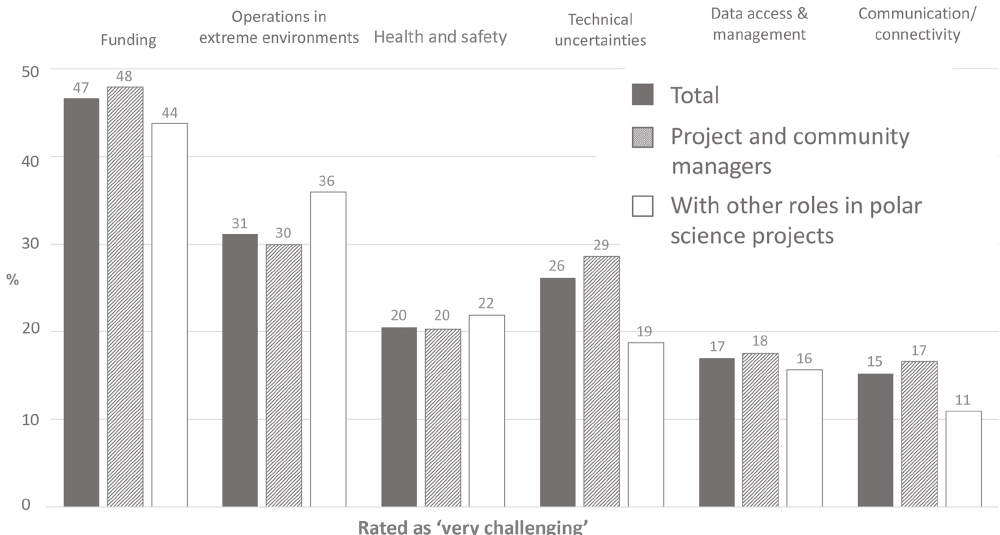
Figure 9. Challenges associated with infrastructure and logistics. Survey respondents (%) rating as “5 – very challenging” when asked the questions Q12: Infrastructure/logistics: Please rate (from 1 to 5) the following